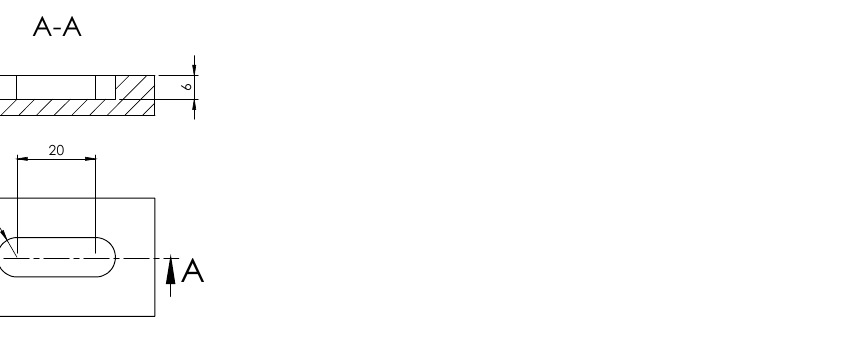
Figure 2. Schematic dimensions in mm of the self-designed wells for the ex vivo experiment.